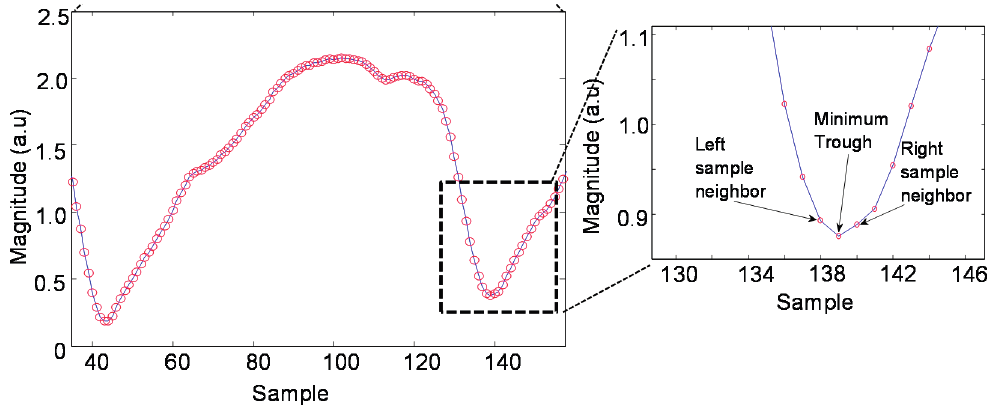
Figure 12. The algorithm of PPG peak and trough-detection (APTRD) developed to detect the trough of pulsatile waveform for HR